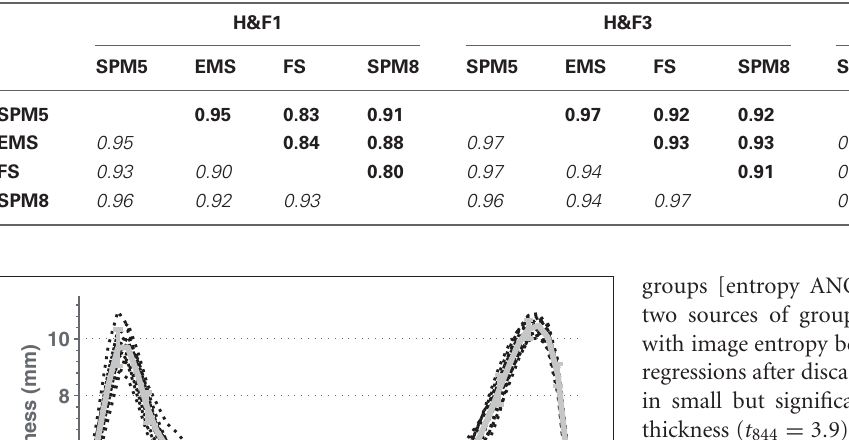
Table 3 | Pearson correlation coefficients for area (upper triangular, bold) and thickness (lower triangular, italic) values between C8 computations applied to the OASIS-152 dataset using four different segmentation preprocessing methods (see the Image Preprocessing section and Supplemental Table S2) within three of the H&F partitions (see Figure 3).